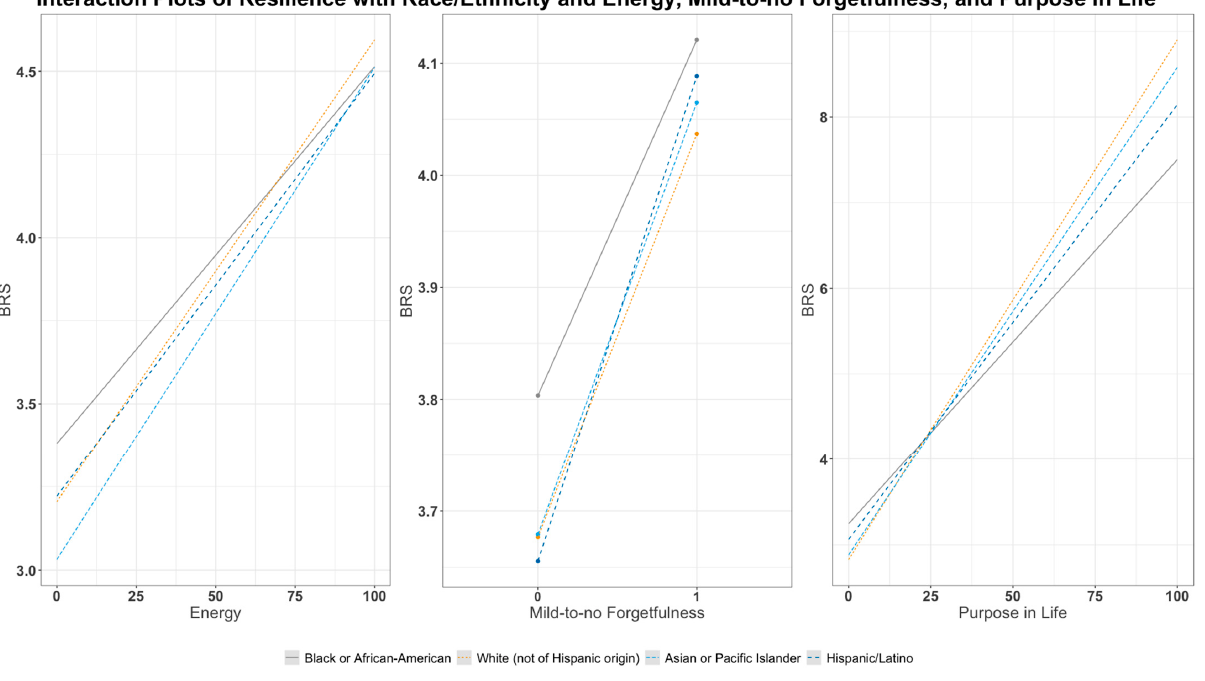
Figure 3. Plot displaying interaction effects between race/ethnicity and energy score, mild-to-no for- getfulness, and purpose in life score as estimated from Model 4, Model 7, and Model